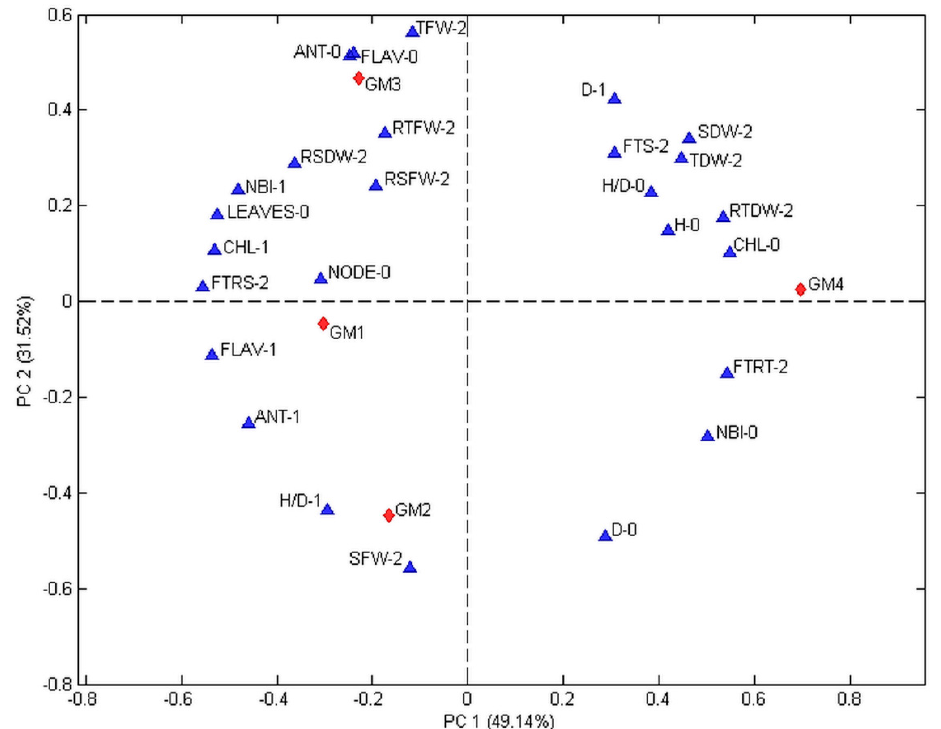
Figure 3. Ordination biplots of principal component analysis outputs of the data from two-year-old vines grown on growing media (GM) containing composted solid digestate (CSD) at different rates. GM1 = commercial peat (CP) 100%; GM2 = CP 90% + CSD 10%; GM3 = CP 80% + CSD 20%; GM4 = CP 60% + CSD 40%. Labels in the triangles indicate the investigated parameters: Leaf chlorophyll content (CHL); leaf flavonoid content (FLAV); nitrogen balance index (NBI); leaf anthocyanins (ANT); plant height (H); height diameter ratio (H/D); shoot fresh weight (SFW); rootstock fresh weight (RSFW); root fresh weight (RTFW); total fresh weight (TFW); shoot dry weight (SDW); rootstock dry weight (RSDW); root dry weight (RTDW); total dry weight (TDW); fraction to shoot (FTS); fraction to rootstock (FTRS); fraction to root (FTRT). 0 = parameter recorded at 170 day of year (DOY); 1 = parameter recorded at 275 DOY; 2 = parameter recorded at 362 DOY.